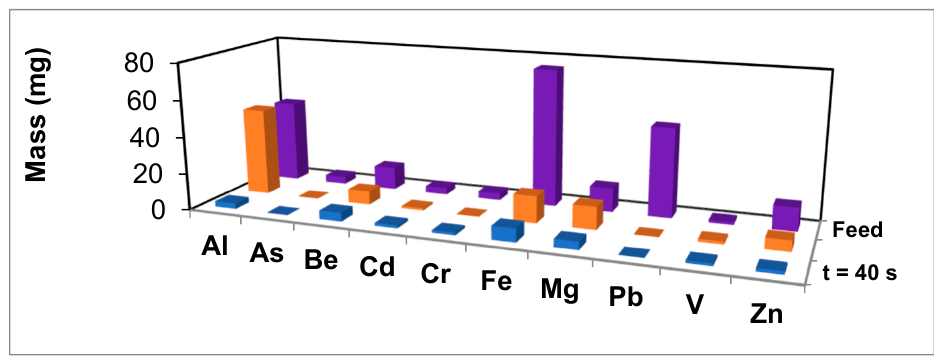
Figure 8. Mass of elements present in phosphate waste before and after treatment.